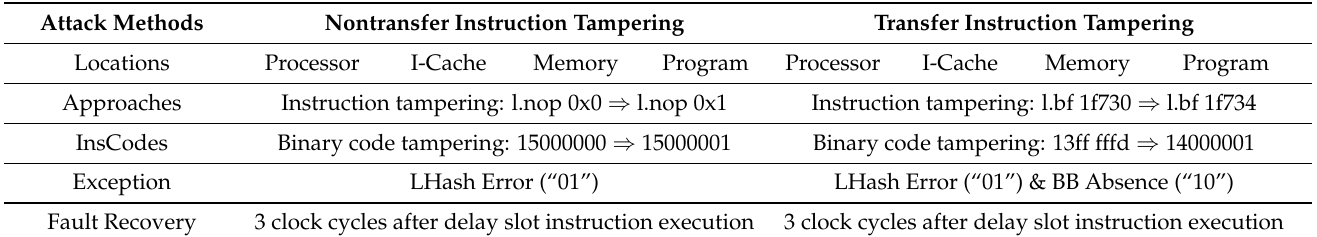
Table 4. Security capability evaluations of the CPU–SPU collaborative SoC under different instruction tampering attacks.